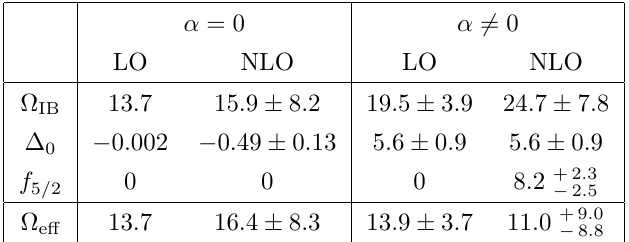
Table 9 . Isospin-violating corrections for (cid:15) 0 =(cid:15) in units of 10 (cid:0) 2 .